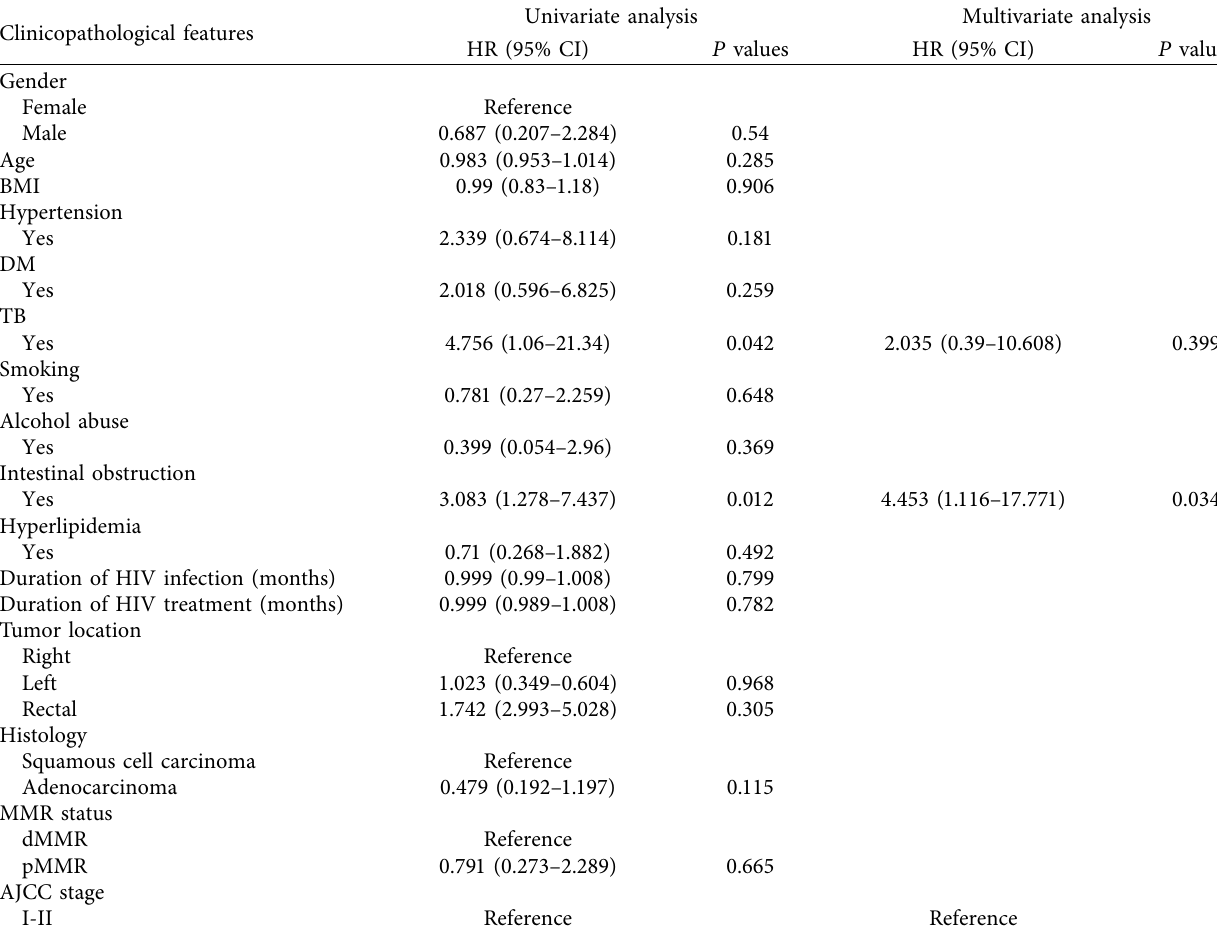
Table 3: Univariate and multivariate analysis of clinicopathologic variables and infammation biomarkers in relation to PFS in patients living with HIV for